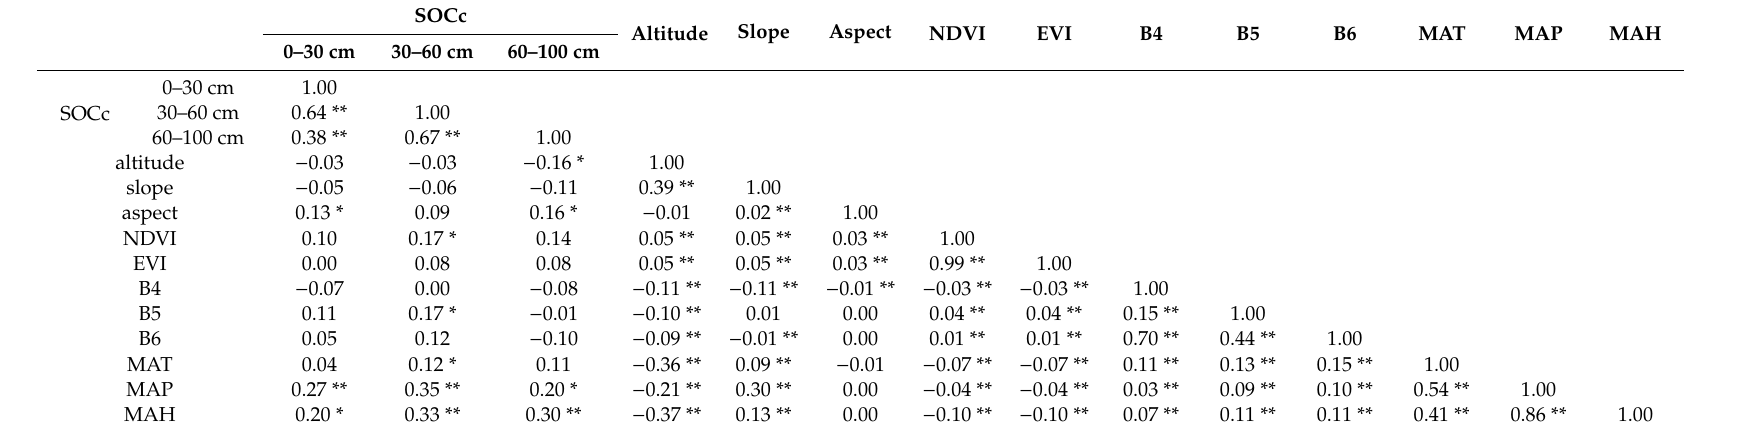
Table 6. Correlation coe ffi cients of wetland SOCc and environmental